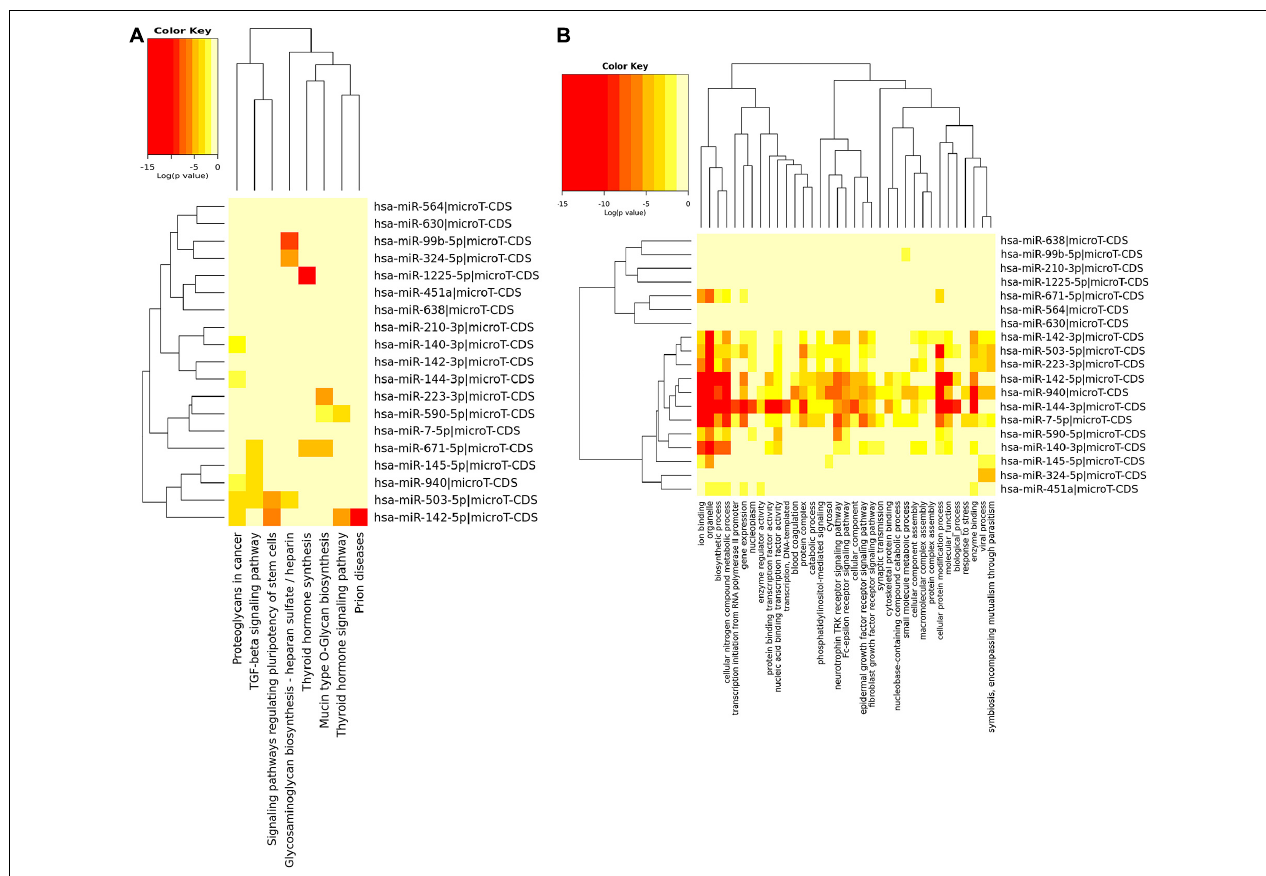
FIGURE 3 | KEGG pathway enrichment analysis (A) and GO enrichment analysis (B) of 19 shared miRNAs based on DIANA-miRPath.